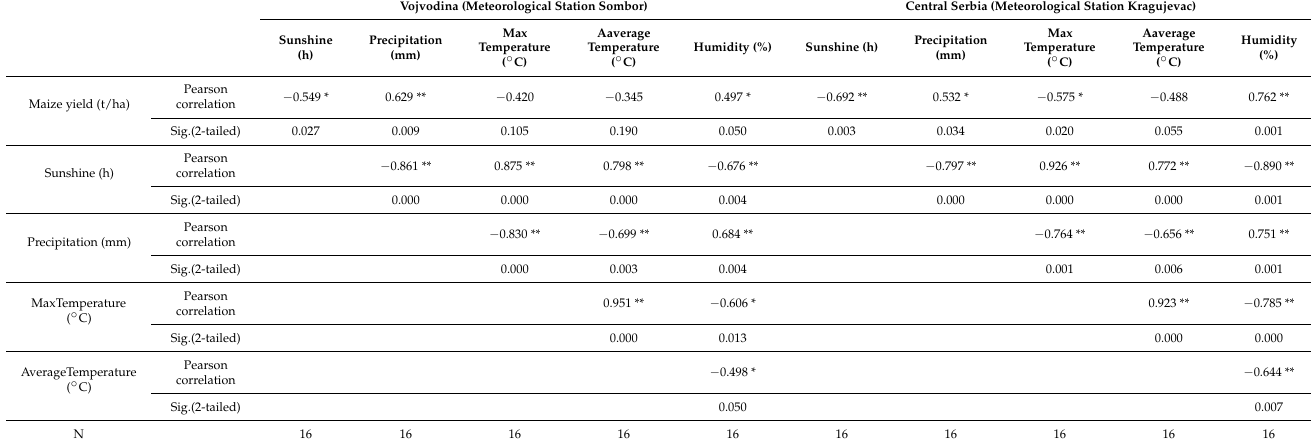
Table 2. Correlation between annual values of climate elements and maize yield (t ha − 1 ) in the Republic of. Serbia in the period